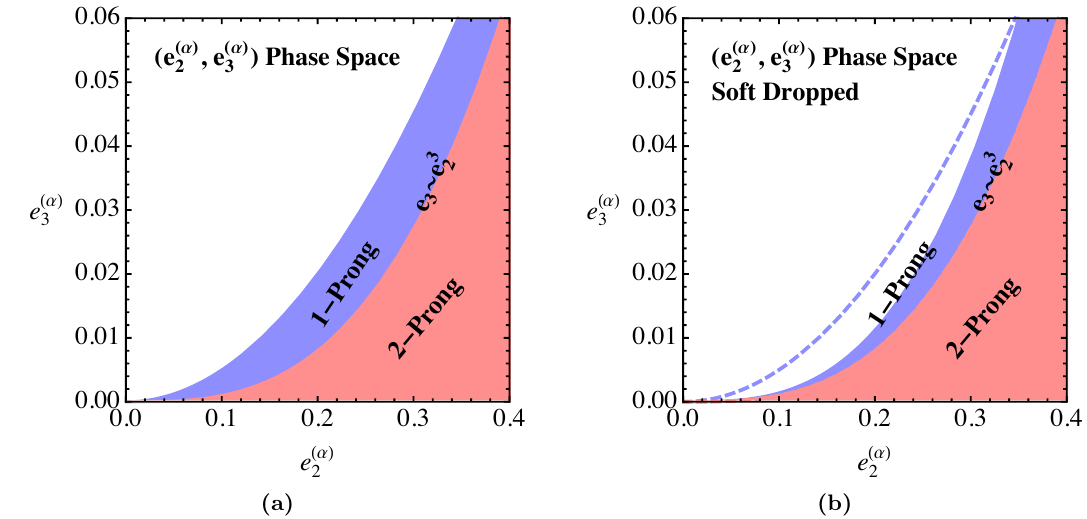
Figure 1. The phase space for one- and two-prong jets on which the energy correlation functions e ( (cid:11) ) and e ( (cid:11) ) 2